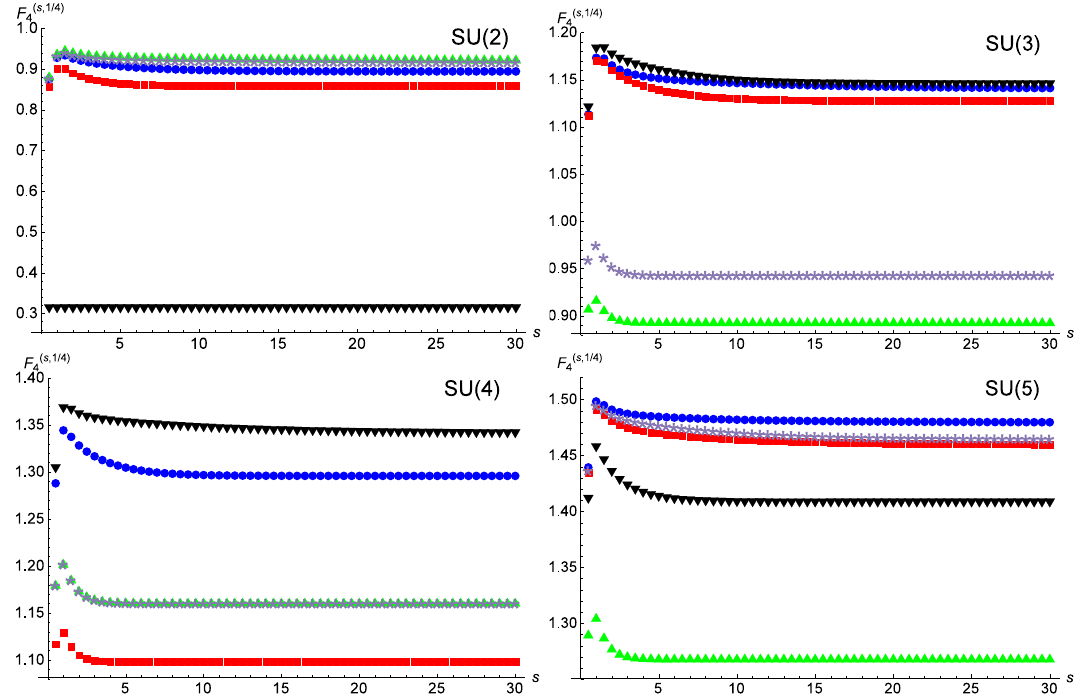
( (cid:28) ) for the spin-0 leading twist op- Figure 1 . s -dependence of the interpolating function F ( s; 1 = 4) 4 erator at randomly chosen (cid:12)ve points (cid:28) = ( r 1 ; (cid:1) (cid:1) (cid:1) ; r 5 ). ( r 1 : blue circle, r 2 : red square, r 3 : green triangle, r 4 : black inverse triangle, r 5 : purple asterisk) [Left-Top] The SU(2) case, ( r 1 ; r 2 ; r 3 ; r 4 ; r 5 ) ’ (0 : 5371+0 : 223 i; 0 : 3408+0 : 6288 i; 0 : 6924+0 : 9223 i; 0 : 9543+0 : 1698 i; 0 : 4806+0 : 6612 i ).